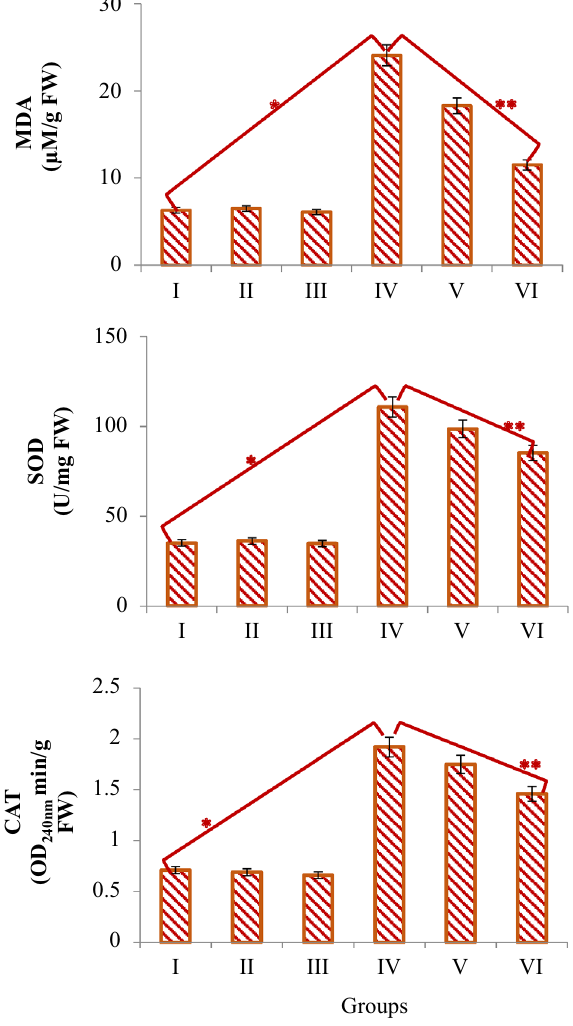
Figure 5. Effect of uranyl acetate and sage application on selected biochemical parameters. Group I: Control, Group II: 190 mg/L sage, Group III: 380 mg/L sage, Group IV: 0.1 mg/mL uranyl acetate, Group V: 0.1 mg/ mL uranyl acetate + 190 mg/L sage, Group VI: 0.1 mg/mL uranyl acetate + 380 mg/L sage. * indicates statistical difference between Groups I and IV, ** indicates statistical difference between Groups IV and VI ( p <